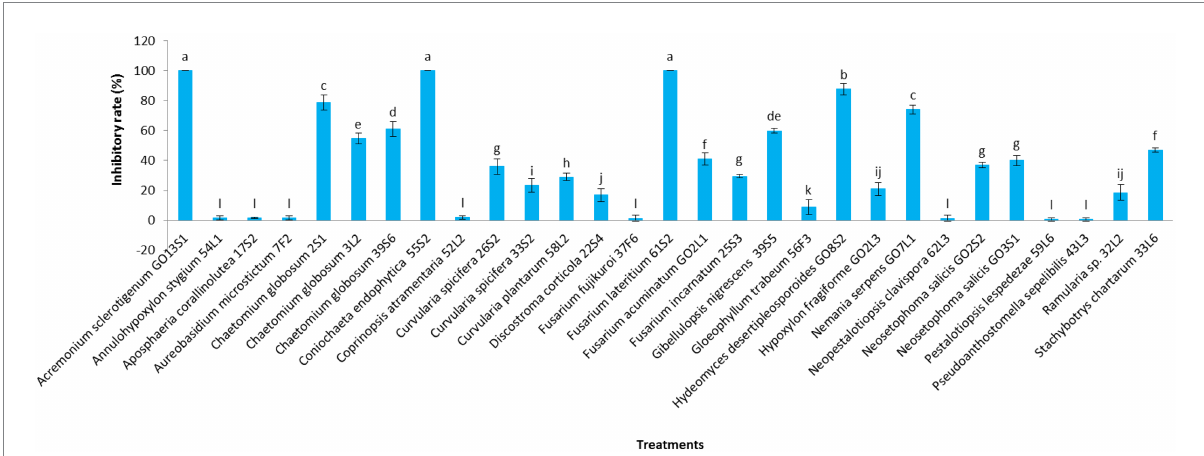
FIGURE 7 Effect of media-permeable metabolites of endophytic fungi isolated from apple on Venturia inaequalis mycelia growth after 1 month in vitro . Data are the means ± SE of three replicates. Values of histograms with common letters are not significantly different at p ≤ 0.01 according to Duncan’s multiple range test.